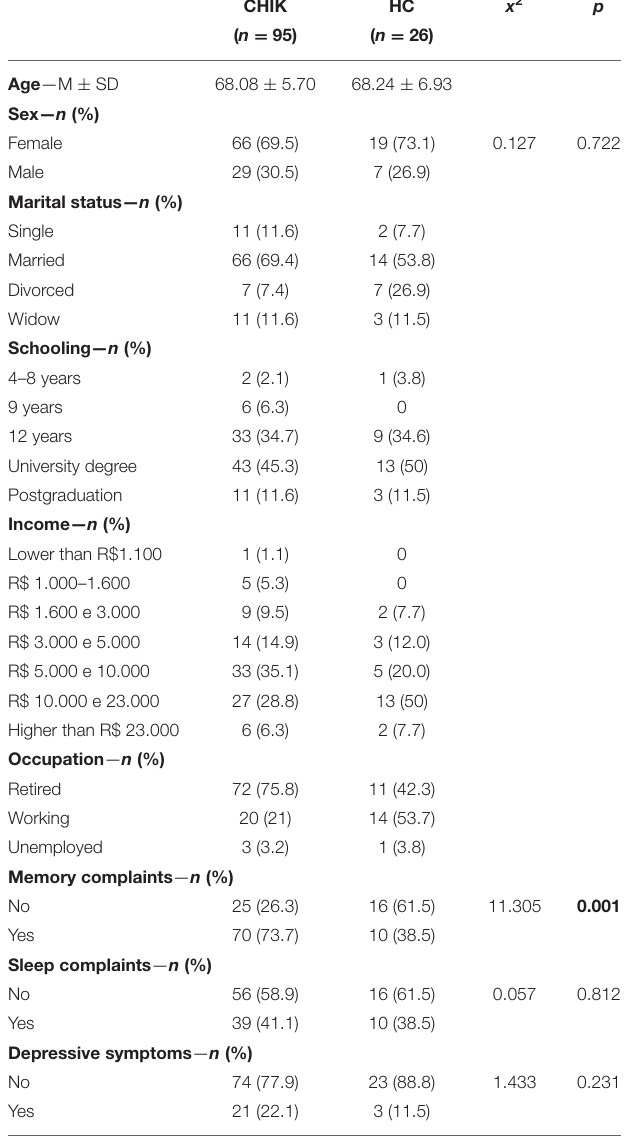
TABLE 1 | Demographic and clinical characteristics by groups (CHIK and healthy